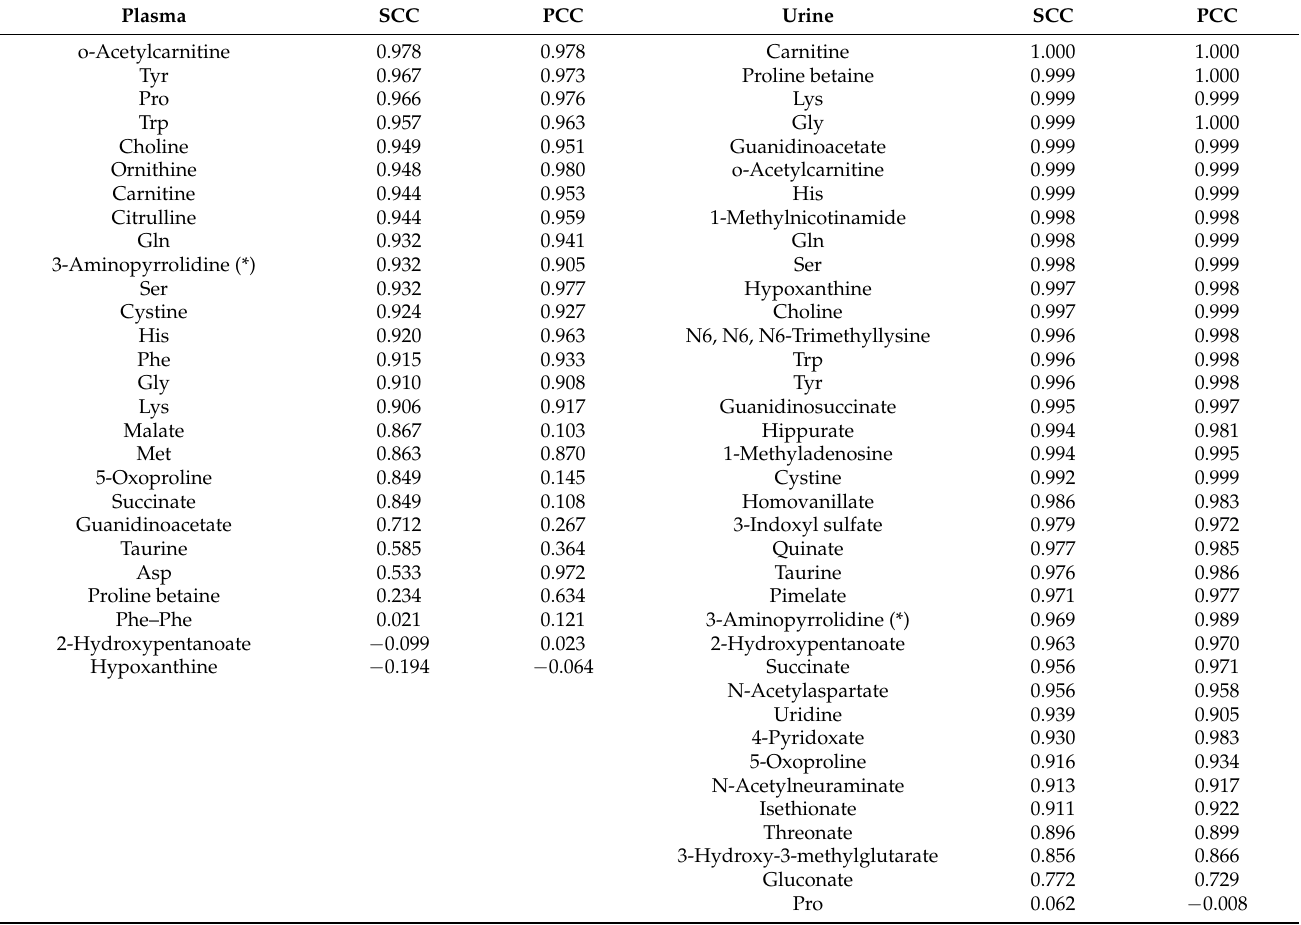
Table 1. Correlation coefficients between corresponding automatically detected and manually curated peak areas. SCC, Spearman’s correlation coefficient; PCC, Pearson’s correlation coefficient, Tyr, Tyrosine; Pro, Proline; Trp, Tryptophan; Gln, Glutamine; Ser, Serine; His, Histidine; Phe, Phenylalanine; Gly, Glycine; Lys, Lysine; Met, Methionine; Asp, Aspartic acid; Phe-Phe, Phenylalanylphenylalanine. (*) Internal standard. Plasma SCC PCC Urine SCC PCC o-Acetylcarnitine